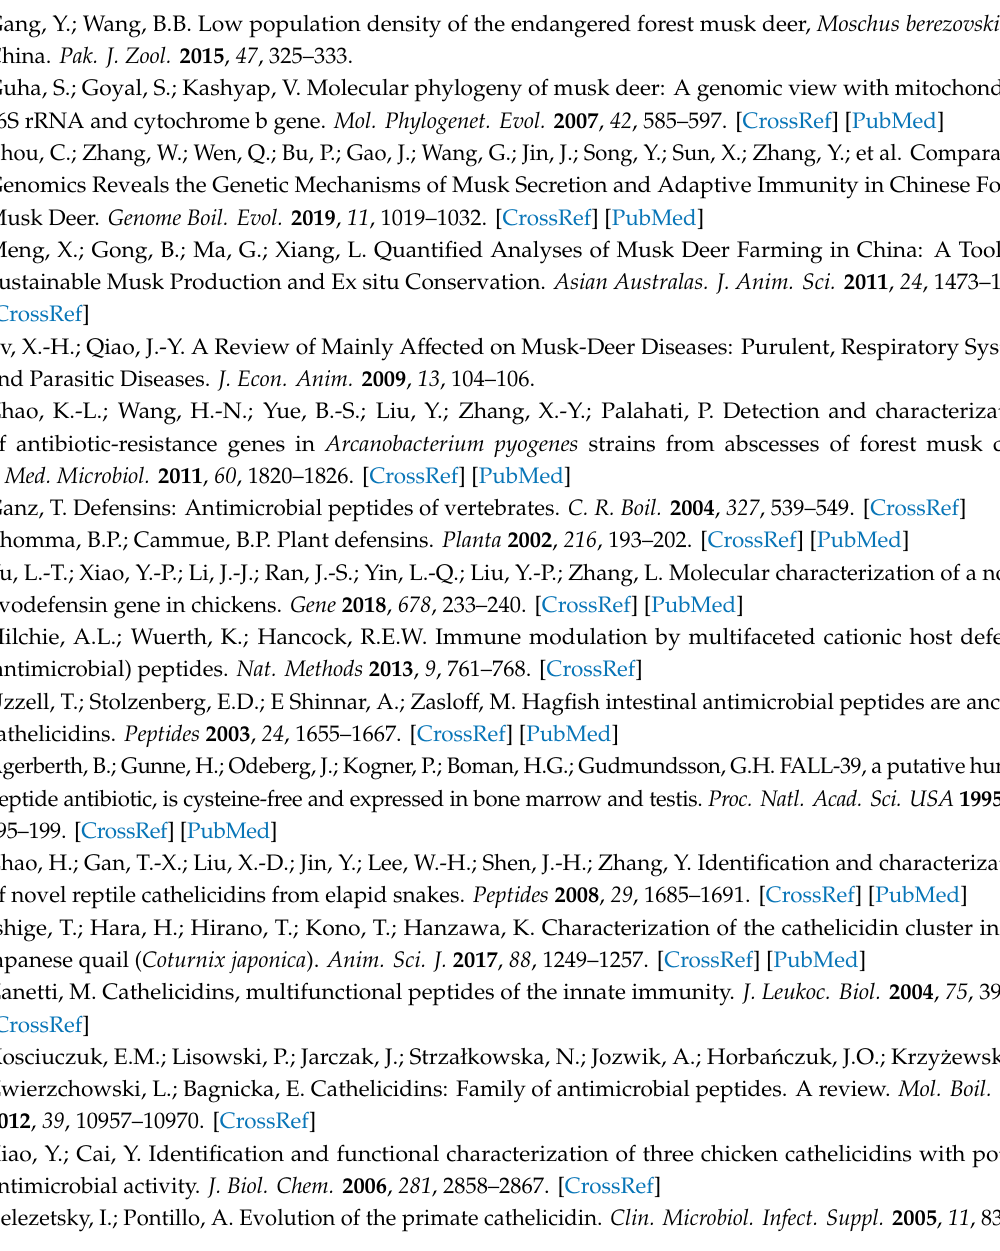
Table S1: Locations and orientations of the forest musk deer cathelicidin genes, File S1: Sequence alignments of the cathelicidins used to create the neighbor-joining